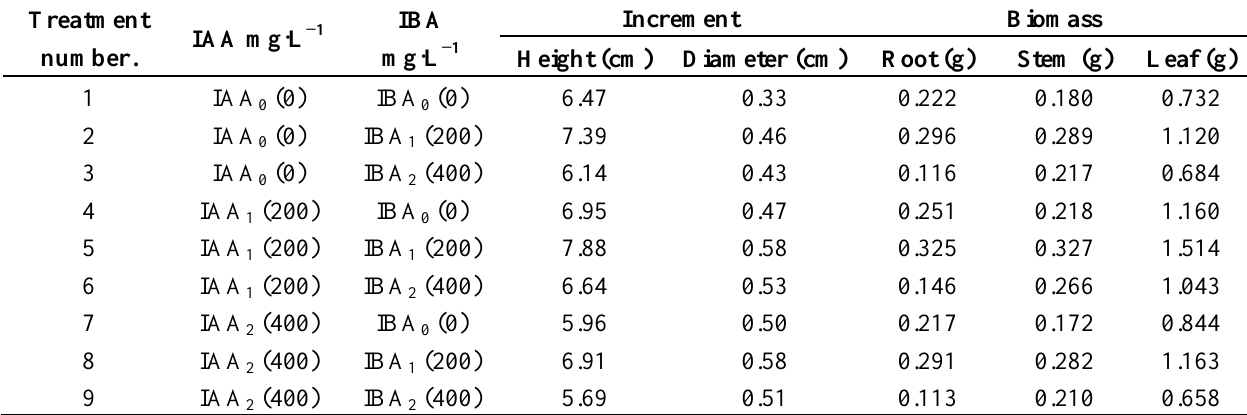
Table 4. Simulation test results of growth index in response to IAA and